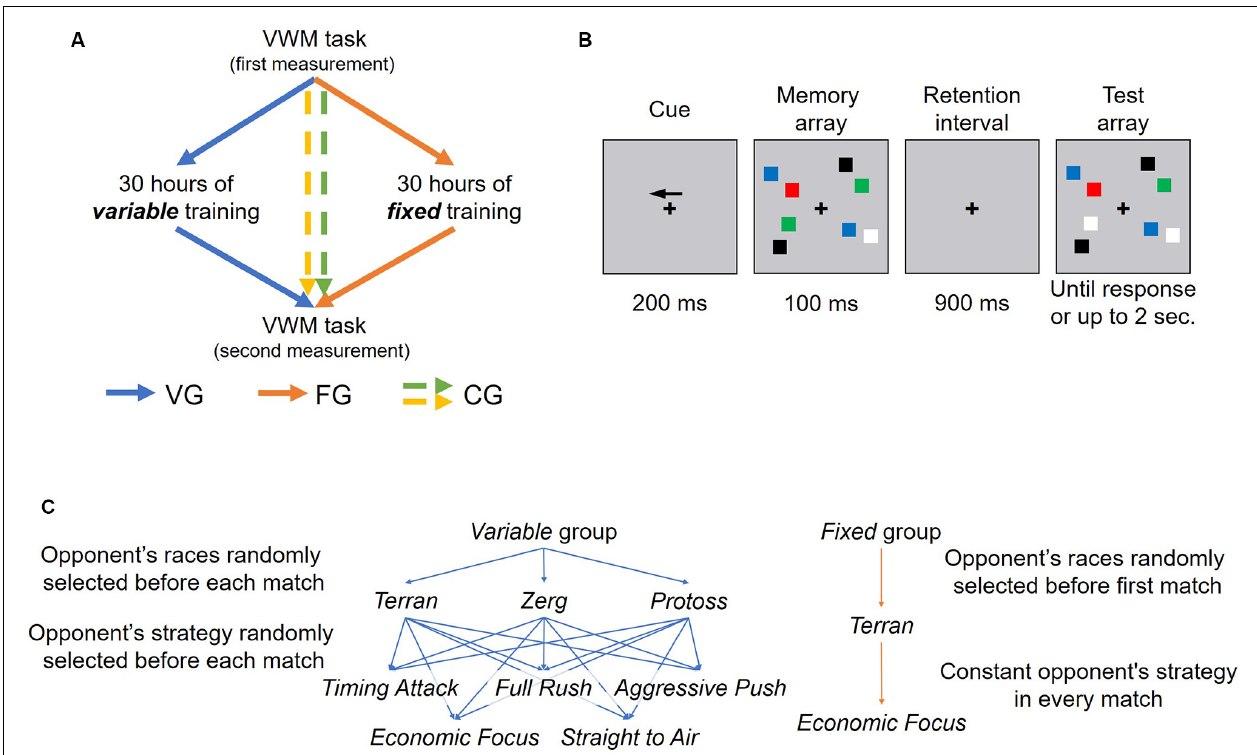
FIGURE 1 | (A) Study design: two measurement sessions were carried out during the study (pre-training and post-training). Training included 30 h of playing in the real-time strategy game ( StarCraft II ), spread over 4 weeks. Training varied depending on the group. The Control group (CG) merges participants from Passive Control, who participated only in the measurement sessions and Active Control, who additionally played Heart Stone for 30 h (8 h in the laboratory and 22 h at home). (B) The visual-working memory task. Participants directed their attention to a cued hemifield (left of right, guided by an arrow at the beginning of each trial) and compared two arrays of colored squares (memory and test arrays) separated by a retention interval. The test array was either identical to the memory array (no-change condition) or differed by one color (change condition). Participants answered whether the two arrays were identical or not. (C) While all of the participants from training groups played as a Terran faction during training, the opponent’s race and strategy varied according to the training group type. Participants from the Variable Environment Group (VEG) could match three factions, from each could use one of five strategies. The faction and the strategy were randomly selected before each match for the Variable group. In the case of a Fixed Environment Group (FEG), participants always played against the Terran faction, which used an economic